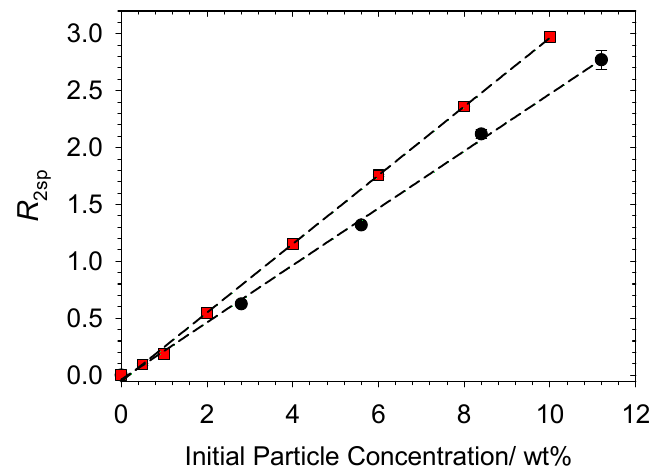
Figure 2. Enhancement in R 2SP as a function of particle concentration: Symbols: ● , Ludox TM-50; ■ , Latex.